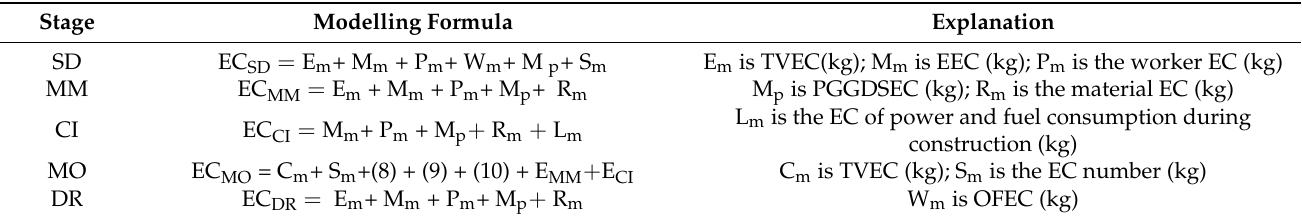
Table 4. Summary table of five-stage modelling formulas [11].